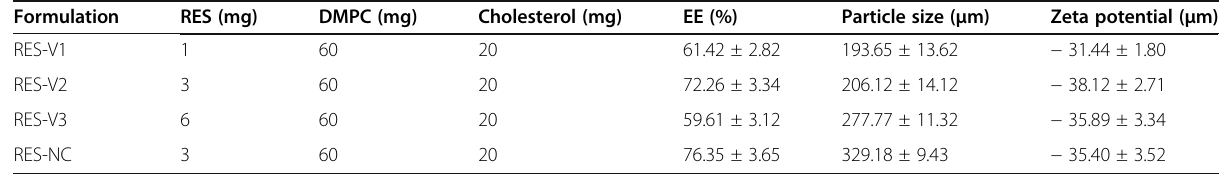
Table 1 Physicochemical characteristics of RES-loaded vesicles (RES-V) and RES-loaded nanocochleates (RES-NC) (mean ± SD, n = 3)